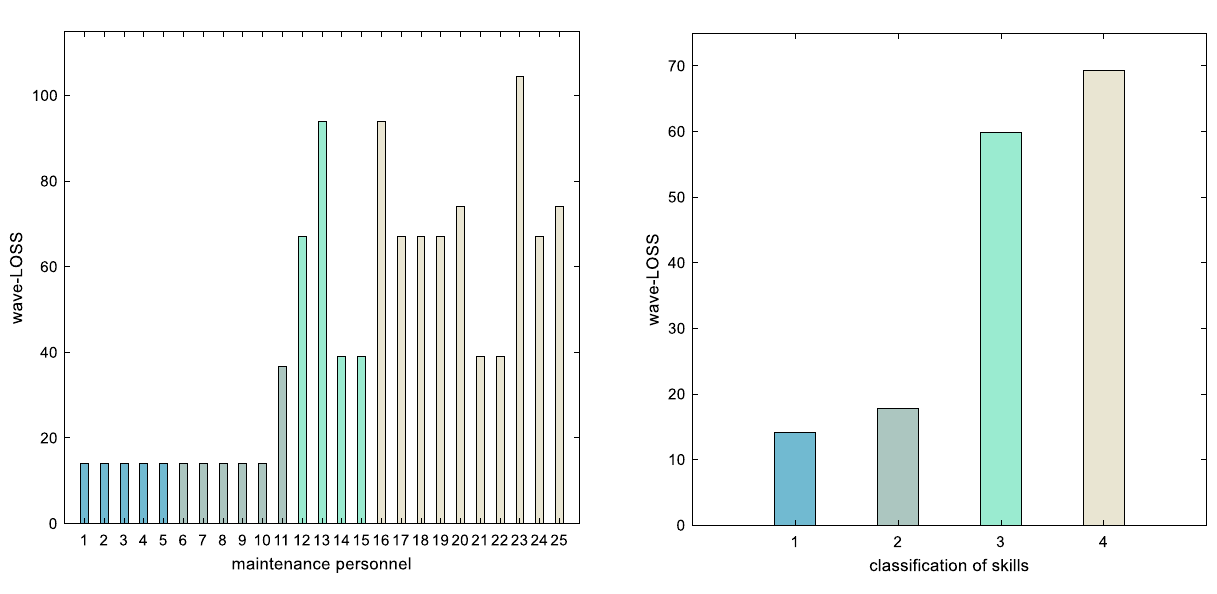
Fig. 21 Correlation between transferred maintenance personnel (classification of skills) and evaluation indexes for 10 carrier-based